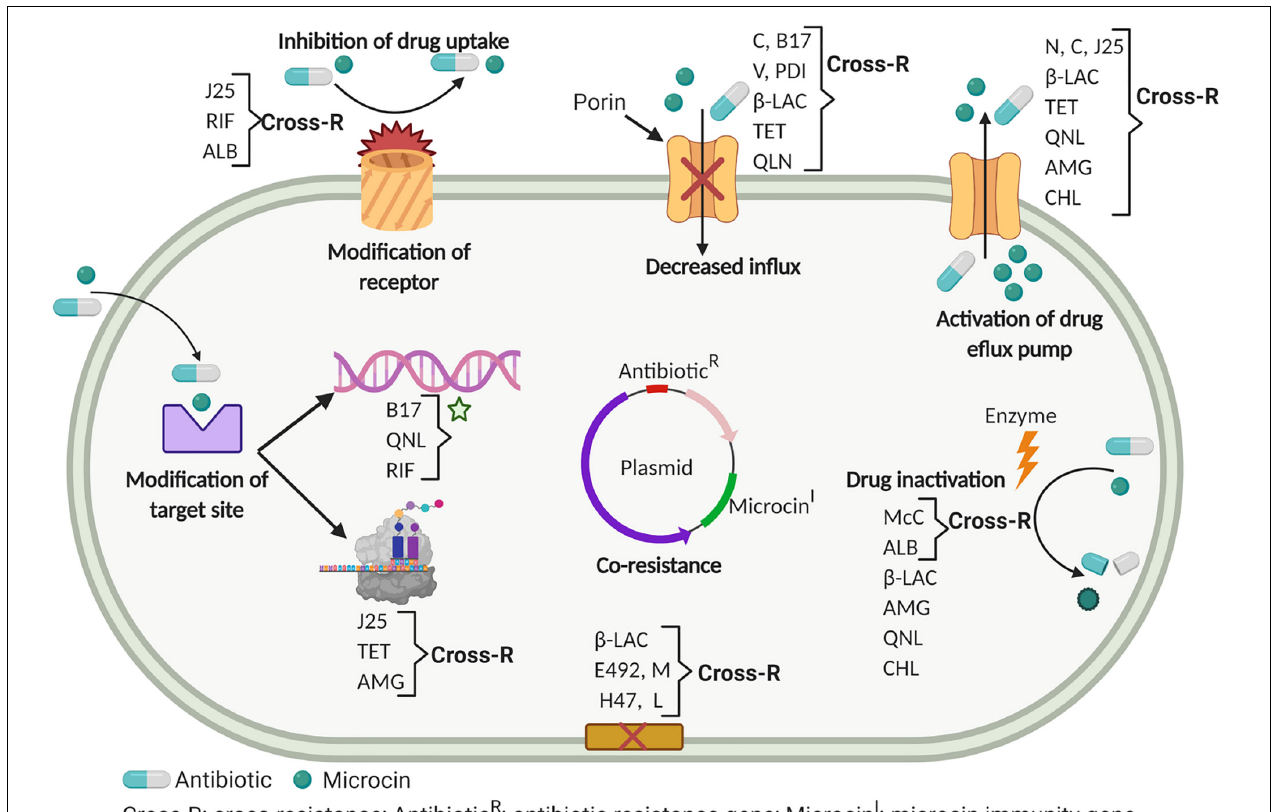
FIGURE 3 | Mechanisms of cross-resistance and co-resistance of antibiotics and microcins in Gram-negative bacteria. β -LAC, β -lactams; QNL, quinolones; TET, tetracycline; AMG, aminoglycosides; FOS, fosfomycin; CHL, chloramphenicol; CS, colistin; RIF, rifampicin; ALB, albomycin.